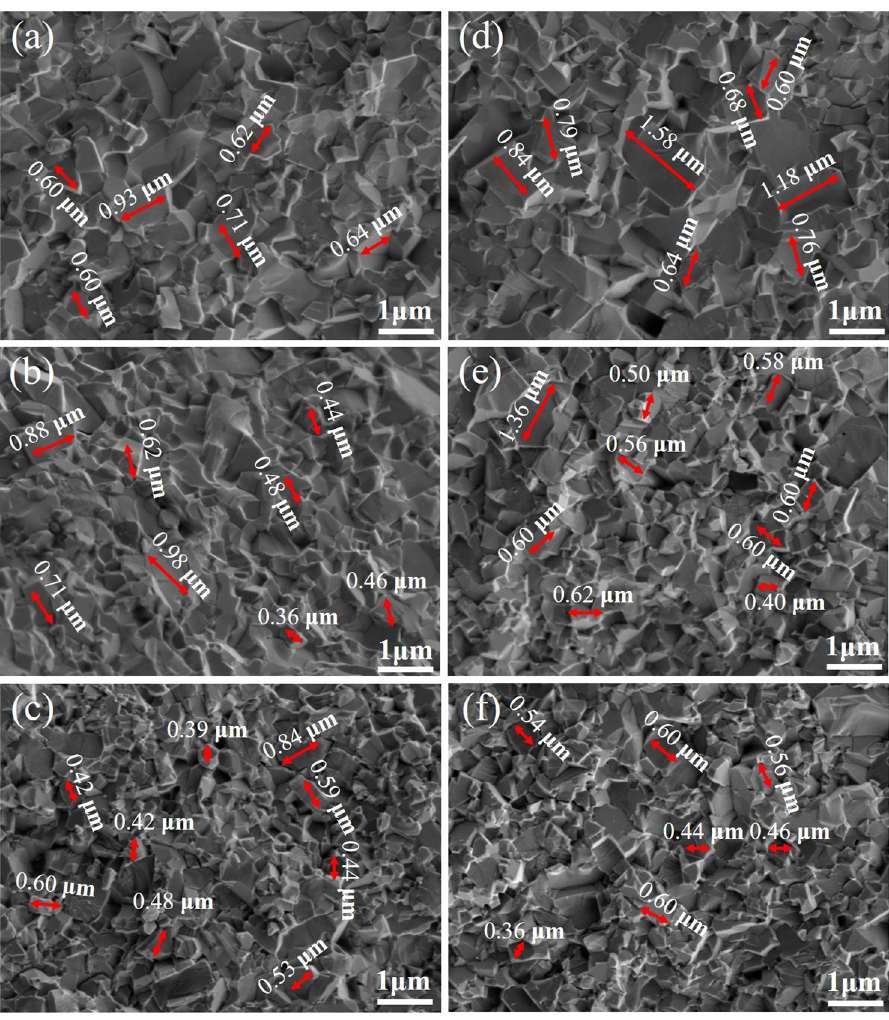
Figure 12: Fracture scanning: ( a ) WCN - 1#, ( b ) WCN - 2#, ( c ) WCN - 3#, ( d ) WCN - 4#, ( e ) WCN - 5#, and ( f ) WCN - WCN - 1# and WCN - 2# were mainly the crystal fracture, and very small wrapped inner holes. The reason is while the specimens WCN - 3 – 6# were mainly transgra - mainly because in the vacuum high - temperature sin - nular fracture. It was observed that the inner crystal tering process, the degree of densi fi cation is mainly grains of the material were planar, and there were few improved by the continuous migration of grain